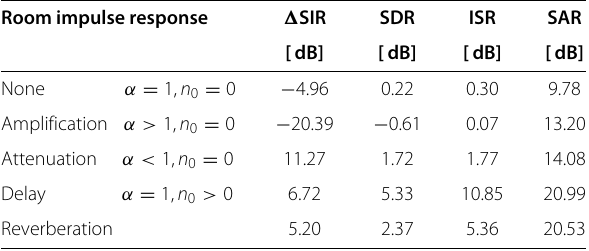
Table 3 MAEC performance results in case of a single-talk scenario with | M | = 3 speakers with various RIRs Room impulse